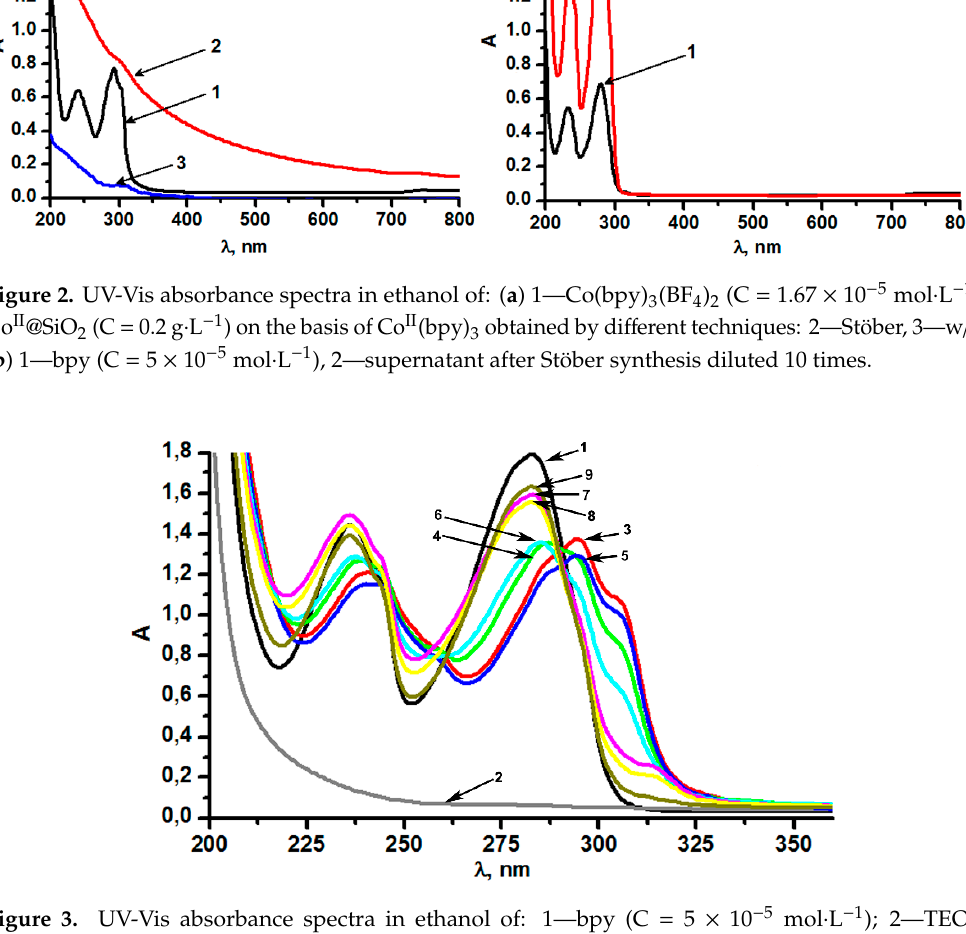
Figure 3. UV-Vis absorbance spectra in ethanol of: 1—bpy (C = 5×10 − 5 mol·L − 1 ); 2—TEOS; 3— 3—Co(bpy) 3 (BF 4 ) 2 (C = 4 × 10 − 5 mol · L − 1 ); Co II (bpy) 3 (C = 4 × 10 − 5 mol · L − 1 ) in the Co(bpy) 3 (BF 4 ) 2 (C = 4×10 − 5 mol·L − 1 ); Co II (bpy) 3 (C = 4×10 − 5 mol·L − 1 ) in the presence of: 4—ammonia